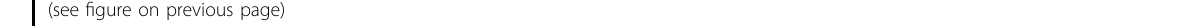
Fig. 3 Caspase-1 inhibition attenuates overload-stimulated cardiac hypertrophy. A1 Representative pictures showing mouse hearts in the indicated groups. A2 Proportion of heart to body weight in the indicated groups. B1 Representative images showing the cross-sectional area of cardiomyocytes of the left ventricle in the indicated groups. Heart tissues were immune-stained with WGA. Green — anti-WGA. One hundred cells were randomly selected from fi ve sections of each heart. Scale bars: 20 μ m. B2 Quanti fi cation of the cross-sectional area of cardiomyocytes of the left ventricle in the indicated groups. C1 Representative images showing the myocardial fi brosis, assessed using Masson trichrome staining in the indicated groups. Blue areas represent fi brotic staining. Fibrosis was quanti fi ed by fi ve whole LV sections for each heart. Scale bars: 50 μ m. C2 Quanti fi cation of the myocardial fi brosis in the indicated groups. The cardiac structure and function of mice were assessed by echocardiography 4 weeks after TAC. D1 Representative images of M-mode echocardiography for mouse hearts. Quantitative analysis of left ventricular EF ( D2 ), LVEDd ( D3 ), LVEDs ( D4 ), and LVPWd ( D5 ). E Survival curves of mice using Kaplan and Meier. Characteristic images ( F1 ) and measurement ( F2 ) of the cell surface area of cardiomyocytes. Cardiomyocytes were stained with cardiomyocyte marker α -actinin (green fl uorescence). Nuclei were marked with DAPI (blue fl uorescence), Scale bars: 20 μ m. In total, 100 cells were selected on random and assessed for surface area for each cohort from six independent trials. Real-time PCR of mRNA expression of cardiac hypertrophy markers BNP ( G ) and β -MHC ( H ). Results are presented as the mean ± SEM, n = 6. ∗ P < 0.01 compared to control, # P < 0.01 compared to TAC group, & P < 0.01 compared to Ang-II